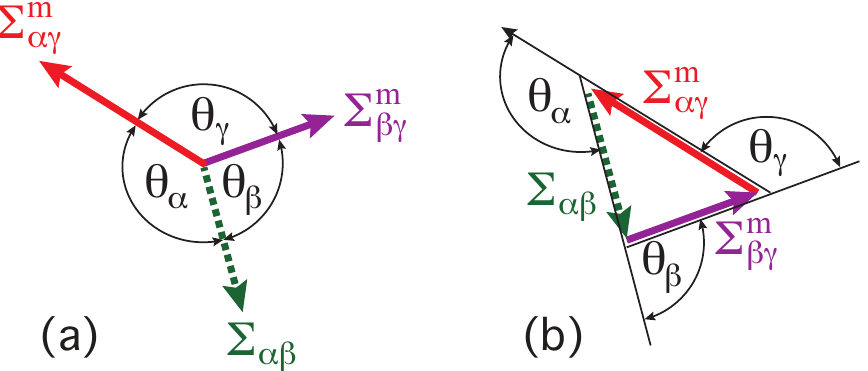
Figure 10. Force balance between the interfacial tension Σ αβ (green) as well as the two membrane segment tensions Σ m (purple), and Σ m αγ (red) for partial wetting by the β droplet which is charac- βγ terized by the relationship θ β < θ α between the apparent contact angles θ α and θ β : ( a ) Each tension generates a force per unit length that pulls at the contact line in the direction of the corresponding arrow. The contact angles θ α , θ β , and θ γ have been introduced in Figure 8; and ( b ) In mechanical equilibrium, the three surface tensions must balance and form a triangle. The contact angles θ i with i = α , β , and γ are the external angles of this triangle while the internal angles of the triangle are given by η i ≡ π − θ i